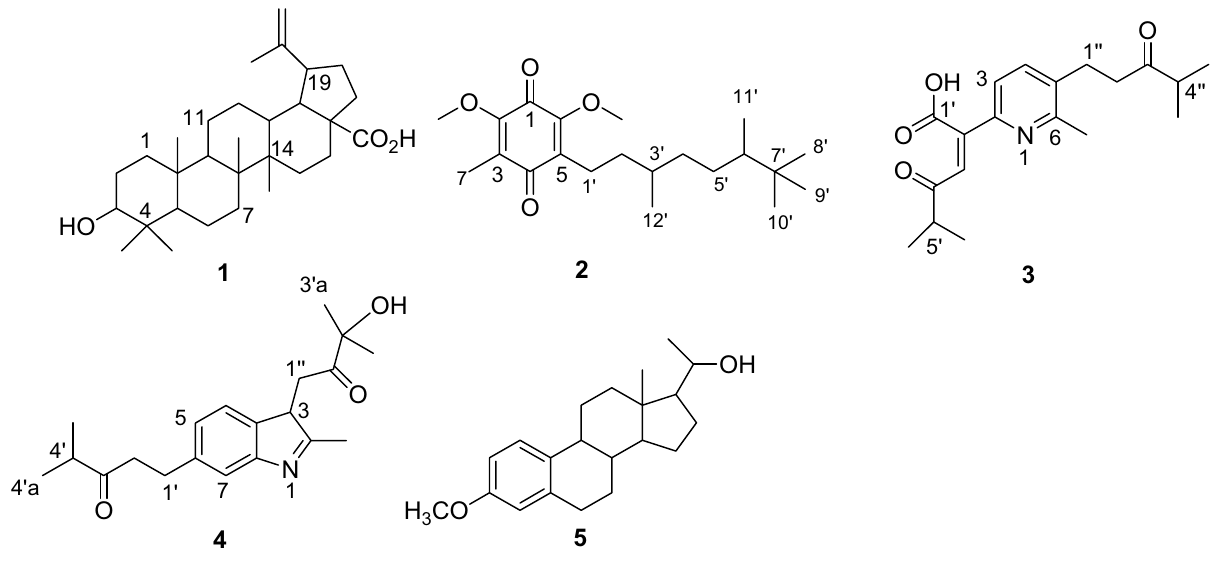
Figure 1. Structures of compounds 1–5 drawn by ChemDraw Pro 16.0 Suite (PerkinElmer,